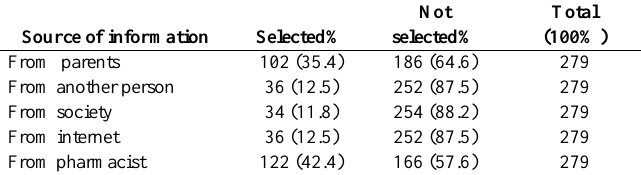
Table 3: The most common illnesses that encountered by the study